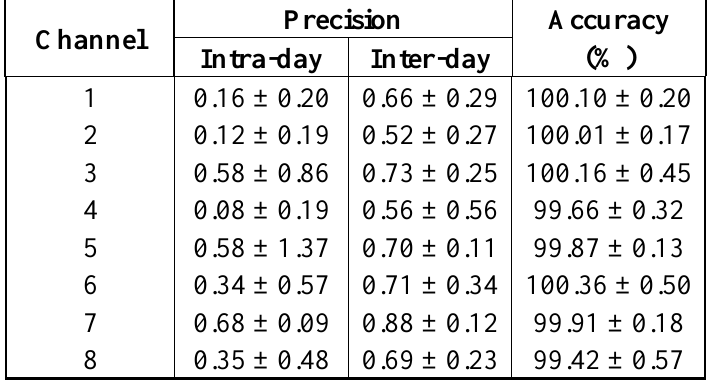
Table 1. Precision and accuracy of each channel of